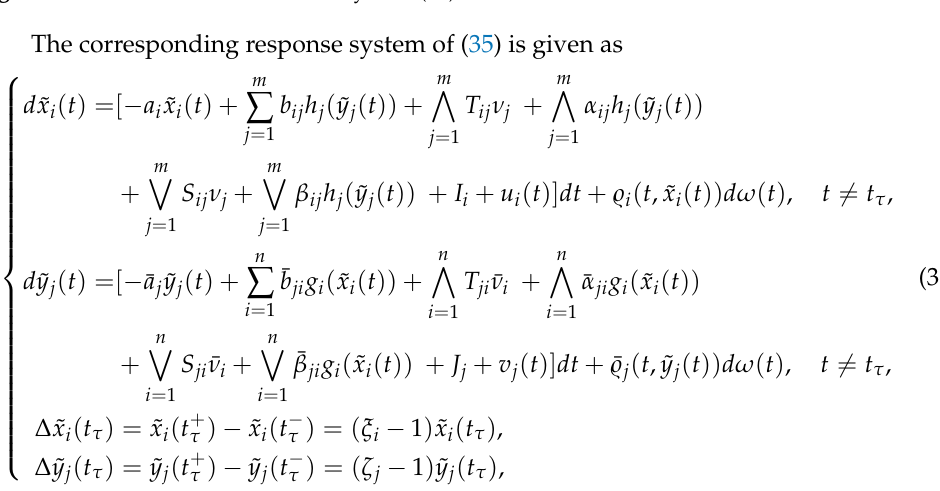
Figure 4. The chaotic attractor of the system